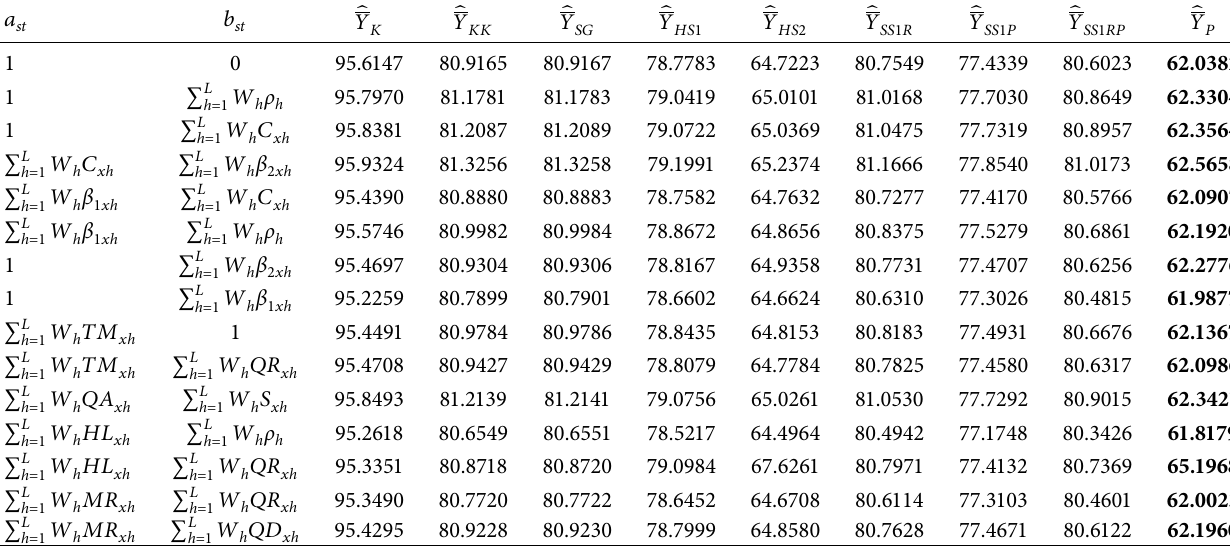
Table 10: Minimum MSEs of different estimators based on the simulation study ( n � 350).